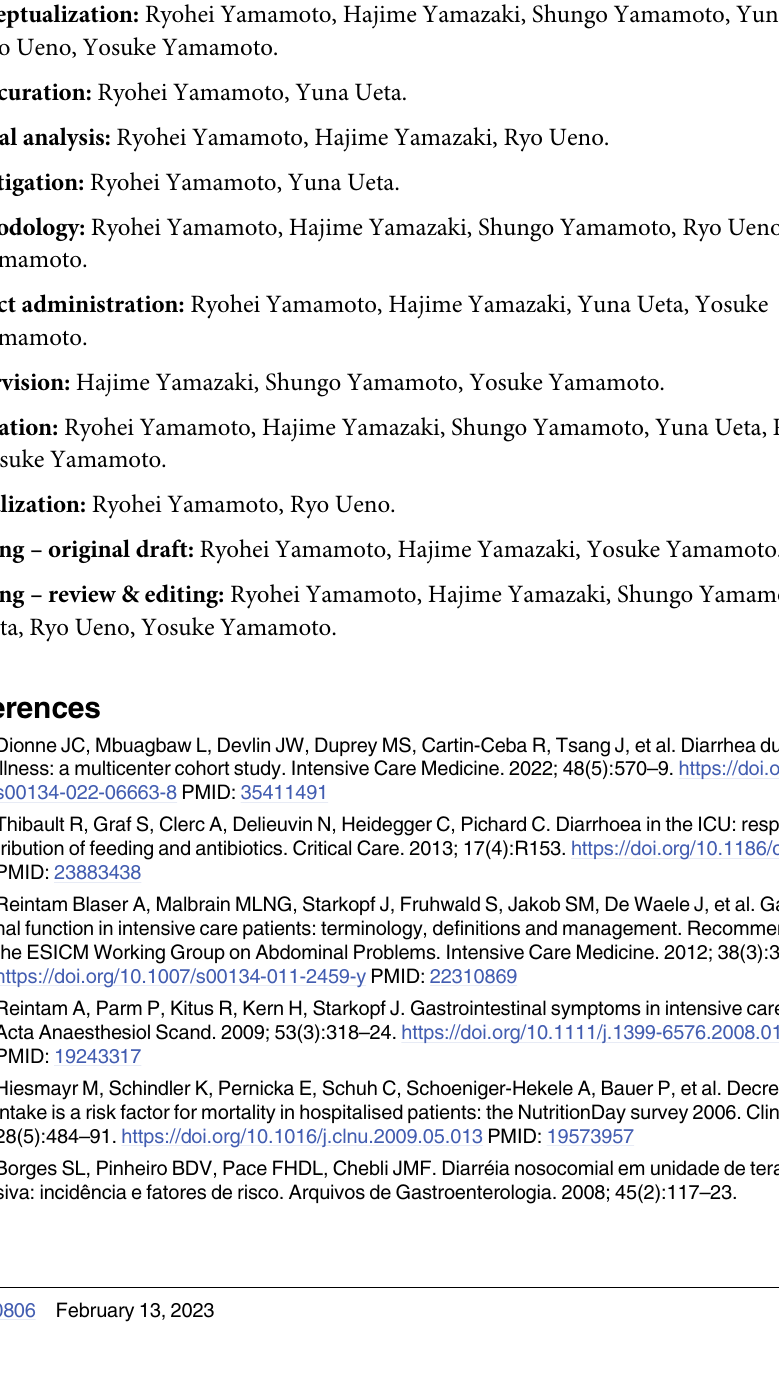
S1 Table. The mortality and length of stay of the entire